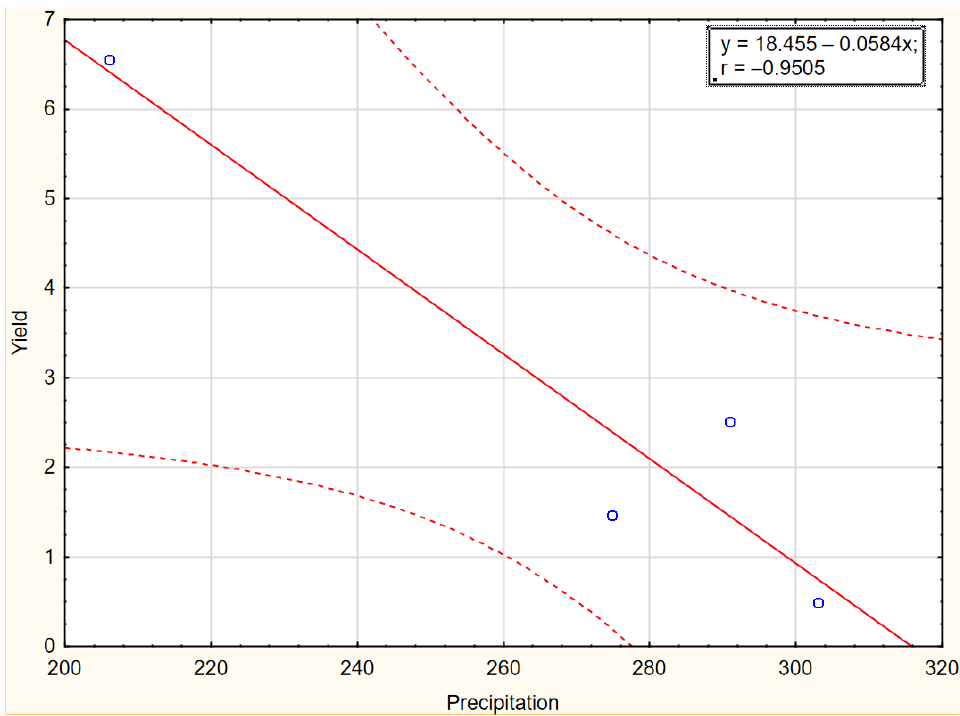
Figure 6. Scatter plot with correlation coefficient for yield and precipitation in 2019–2022.